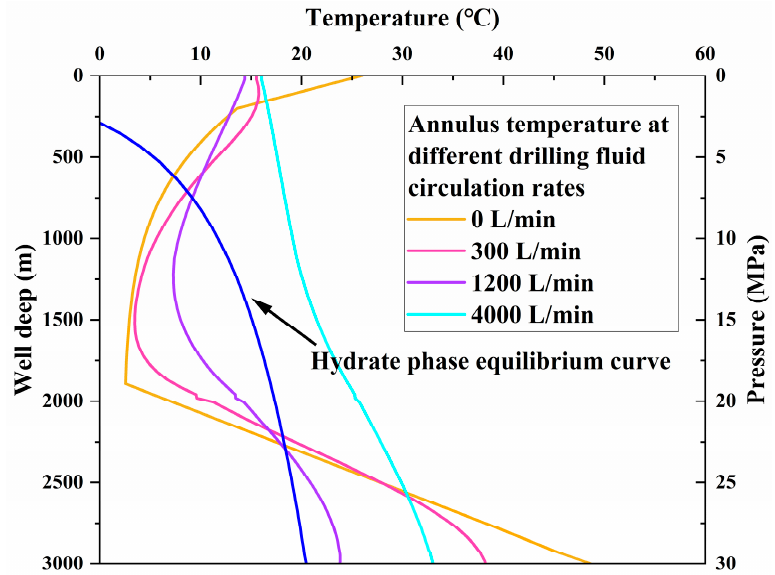
Figure 1. Risk of gas hydrate formation in the wellbore at different drilling fluid circulation rates.